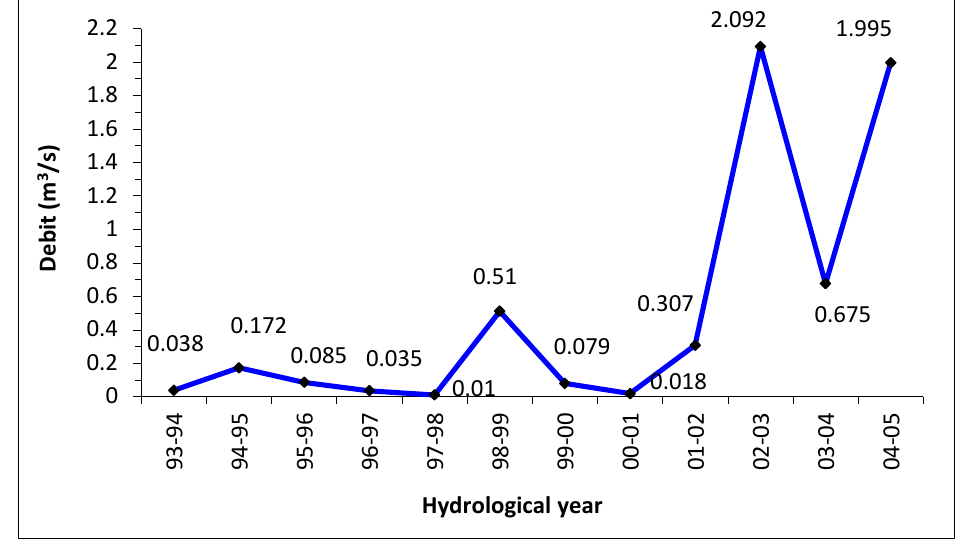
Figure 29. Fluctuation of the average annual flow at the hydrometric station of Athménia River located upstream near the lake of Hammam Grouz dam, Algeria